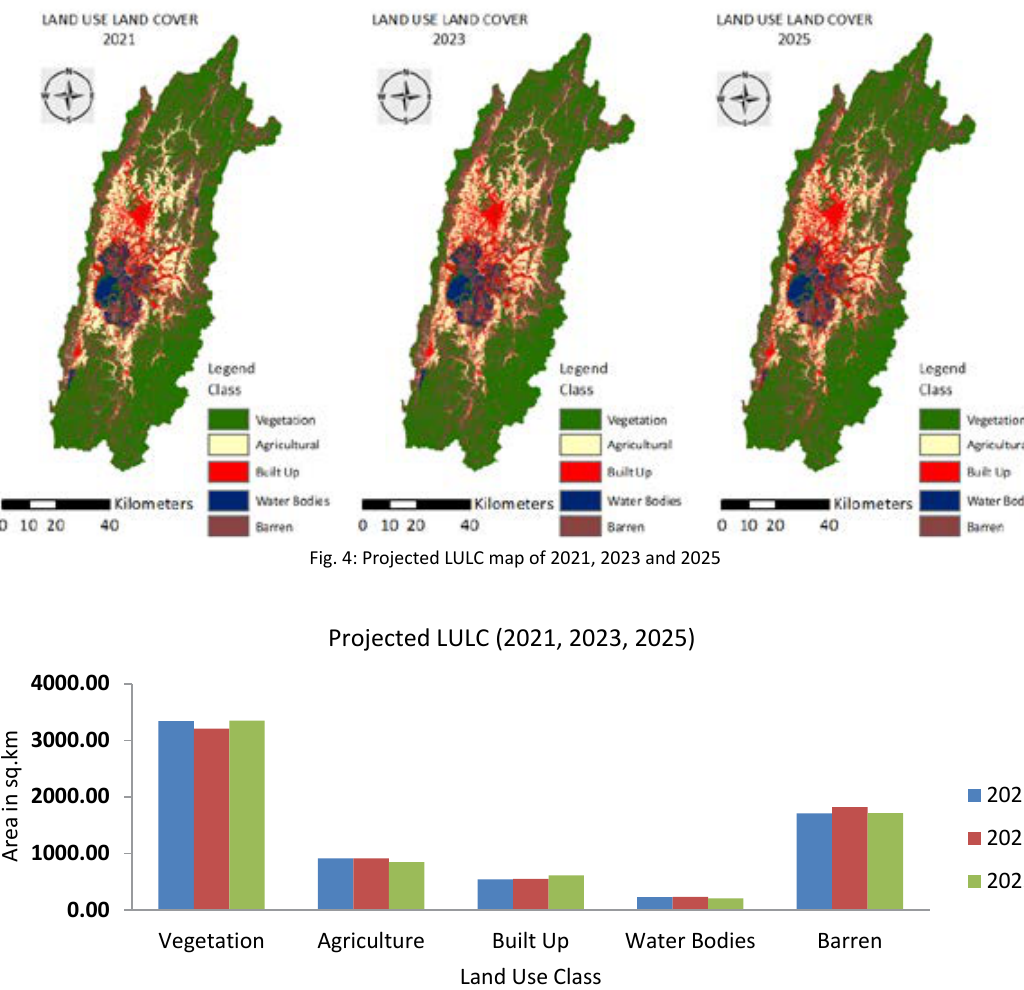
Fig. 5: Area under different LULC classes of 2021, 2023 and 2025